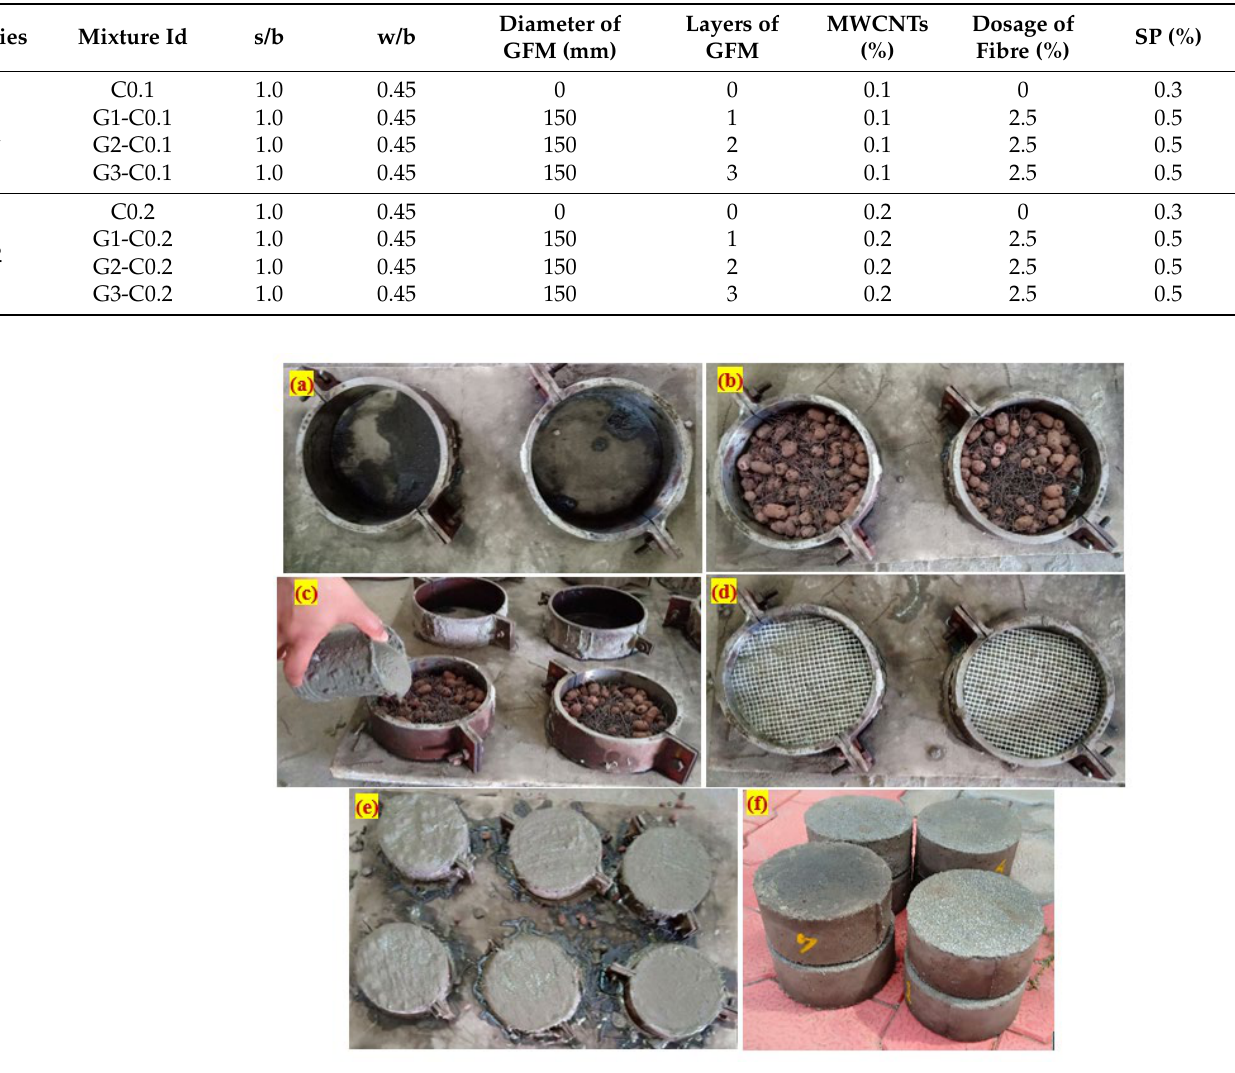
Figure 3. Casting method. ( a ) Empty cylindrical mould; ( b ) ECA and fibres are premixed and filled into the empty mould; ( c ) Grout pouring; ( d ) GFM insertion after the first layer of concrete; ( e ) Finished specimens; ( f ) Appearance of the specimen after demoulding.